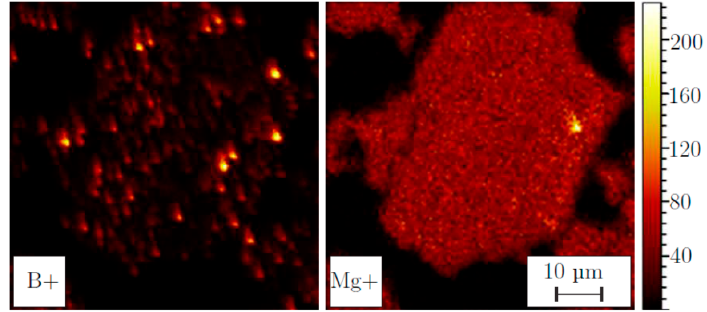
Figure 5. ToF-SIMS mapping on the powder section of composite powder reinforced with 10 vol % SiC and 3 vol % boron; matrix material: AA2017; size of the SiC and B particles: about 1 µ m. A reliable determination of the chemical composition by means of EDX is not possible due to the small size of the phase particles. Due to the low quantity and the low content, detection by XRD